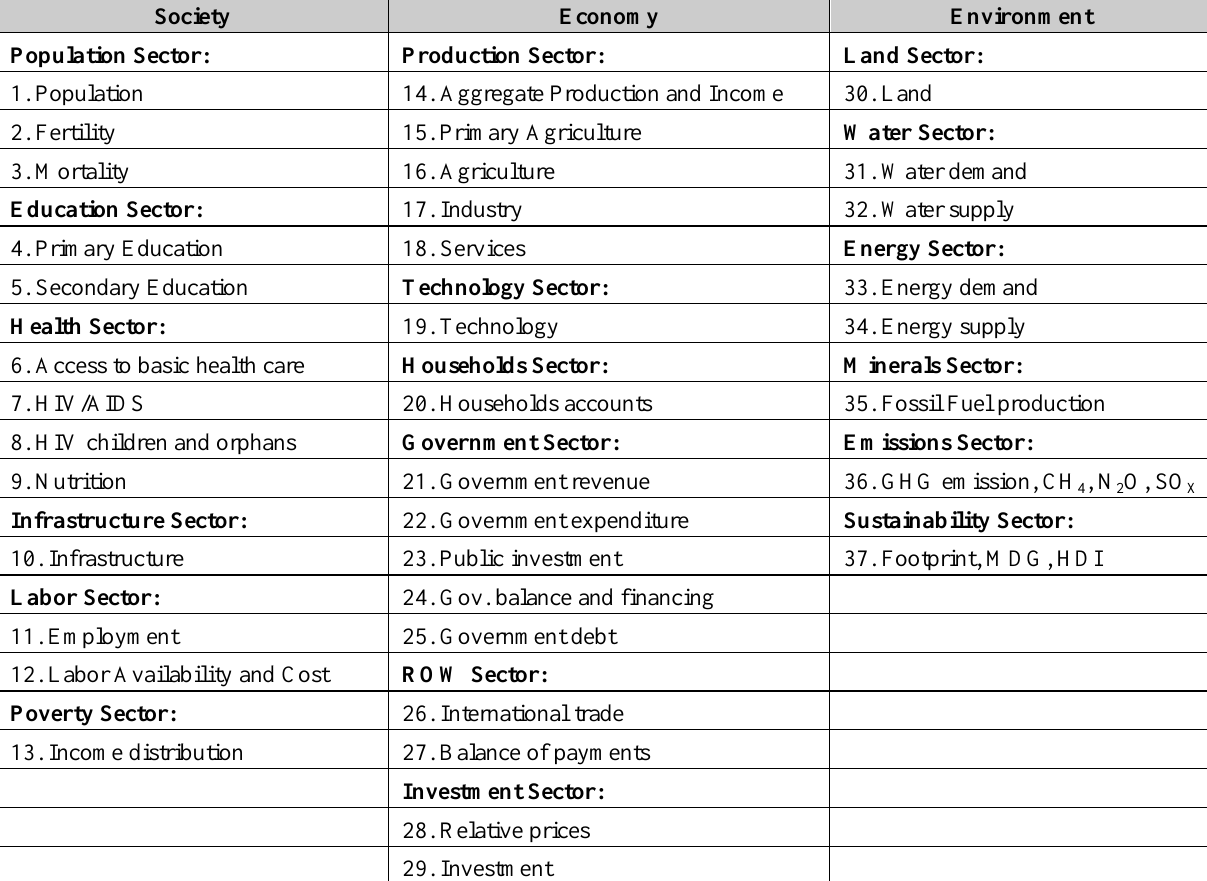
Table 1. Modules, Sectors and Spheres of T21-Starting